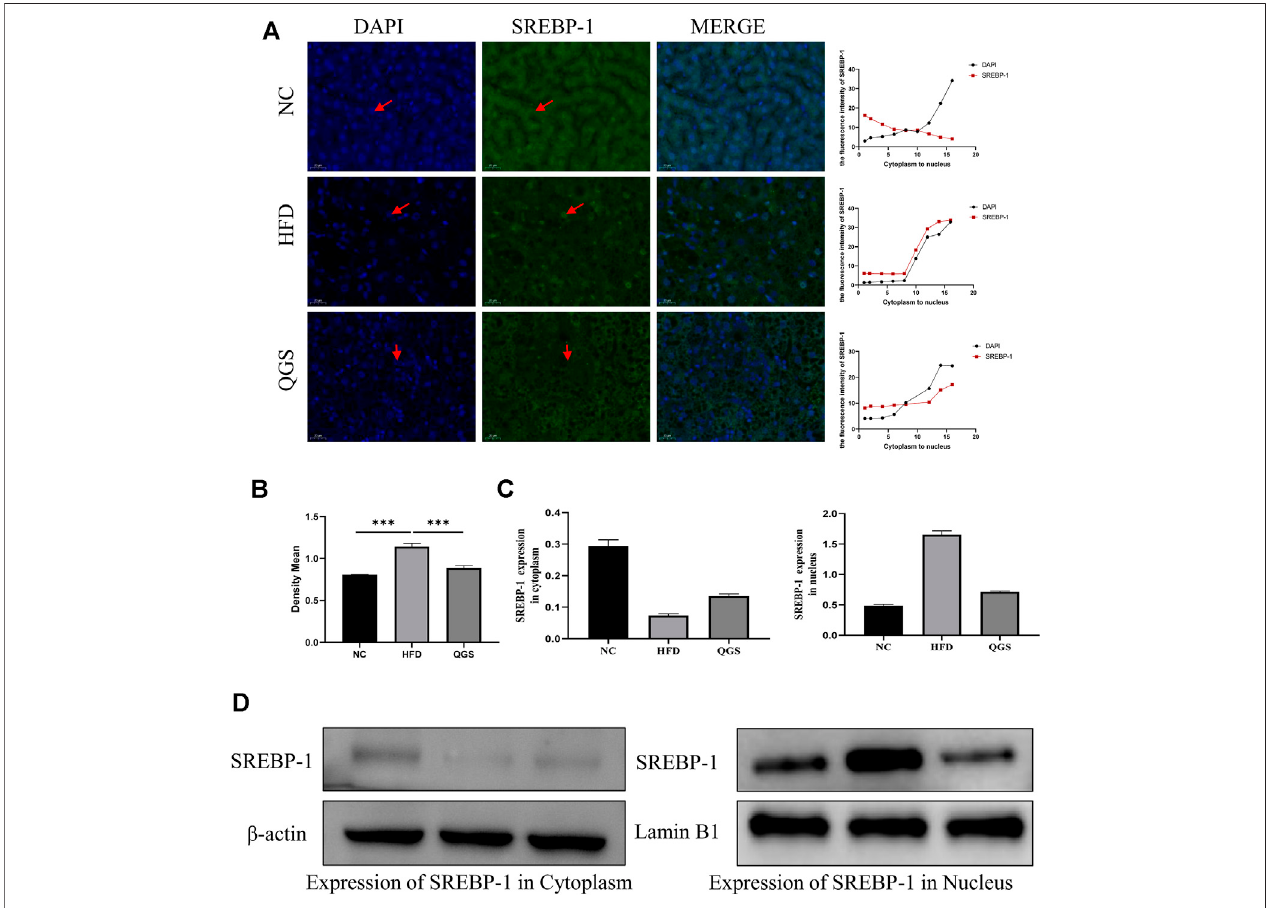
FIGURE 7 | Effects of QGS on the expression of Srebp-1 in the cytoplasm and nucleus. (A) Immuno fl uorescence staining for Srebp-1 in liver tissue (original magni fi cation, × 200).Thelinechartpresentsthetrendofexpressionfromthecytoplasmtothenucleus. (B) Therelativeproteinexpressioninimmunohistochemistrywas quanti fi ed using ImageJ software. The results are represented as the density mean (density mean (cid:2) integrated density/area). (C,D) The expression levels of Srebp-1 in the cytoplasm and nucleus were detected by Western blotting. β -actin and Lamin B1 were used as loading controls.